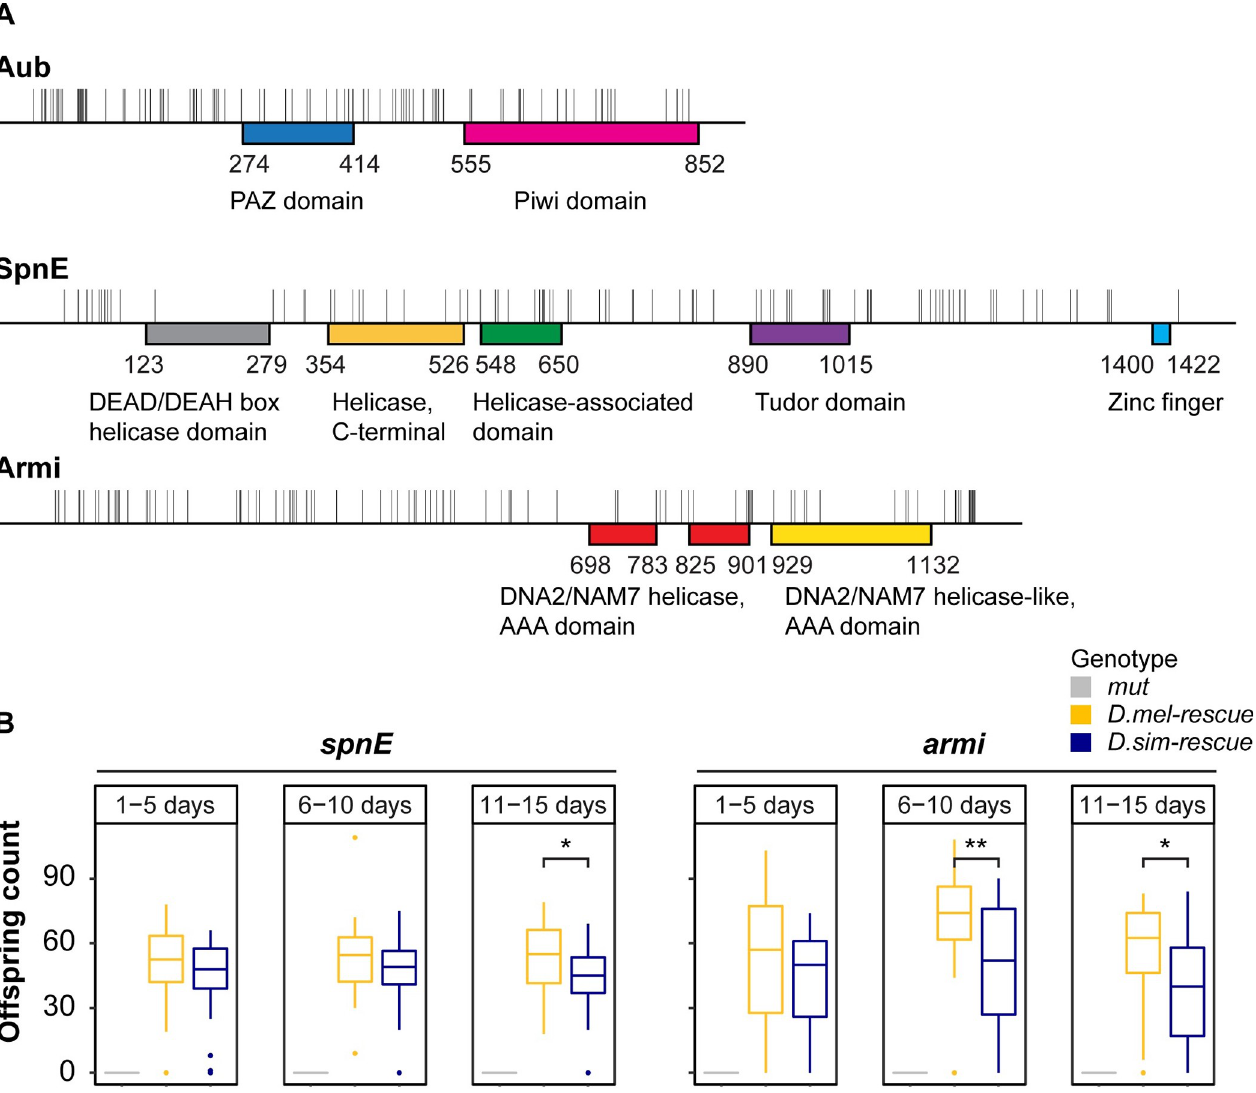
Fig 1. Functional and sequence divergence in piRNA pathway proteins. (A) Amino acid substitutions between D . melanogaster [38] and D . simulans [39] reference alleles are indicated as grey tick marks. Starting and ending amino acids for InterPro [40] annotated functional domains are indicated. (B) Female fertility for D . melanogaster and D . simulans transgenic rescues are compared for three different age classes. Females with the D . simulans spn-E transgene are significantly less fertile across the experiment (Repeated measures ANOVA, F 1,172 = 4.043, p < 0.05) and at the third time point we measured (11–15 days, t 56 = 2.304, p < 0.05). Females with the D . simulans armi transgene are significantly less fertile across the experiment (Repeated measures ANOVA, F 1,175 = 8.824, p < 0.01) and at the second(06–10 days, t 57 = 3.0718, p < 0.01) and the third time points (11–15 days, t 57 = 2.5915, p < 0.05). Sample sizes are 25–35 females. � denotes p � 0.05. �� denotes p � 0.01.